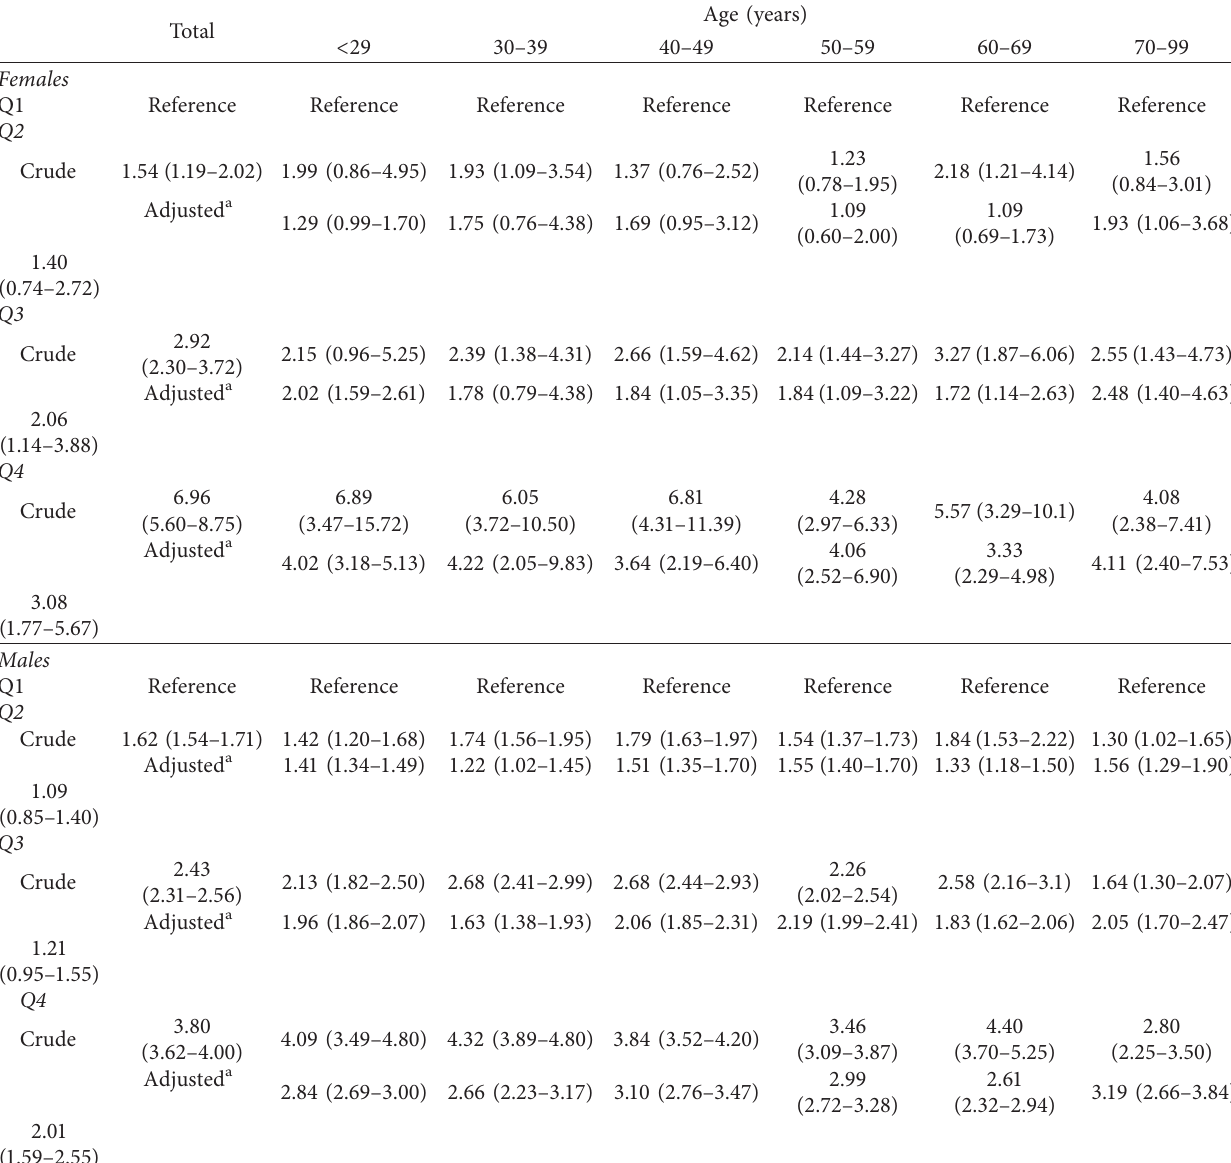
Table 3: The OR (95% confidence interval) of serum urate > 420 μ mol/L according to serum triglycerides quartiles.